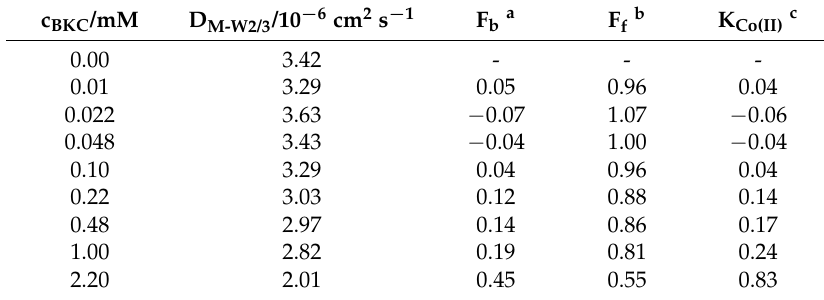
Table 1. Experimentally measured diffusion coefficient of [Co(II)(bpy) 3 ] 2+ complex in micellar solutions by CV (D M-W2/3 ), mole fraction of micellar bound Co(II) complex (F b ), mole fraction of unbound Co(II) complex (F f ), and partition coefficient of Co(II) complex (K Co(II) ) in 0.1 M Na 2 SO 4 containing different concentrations of